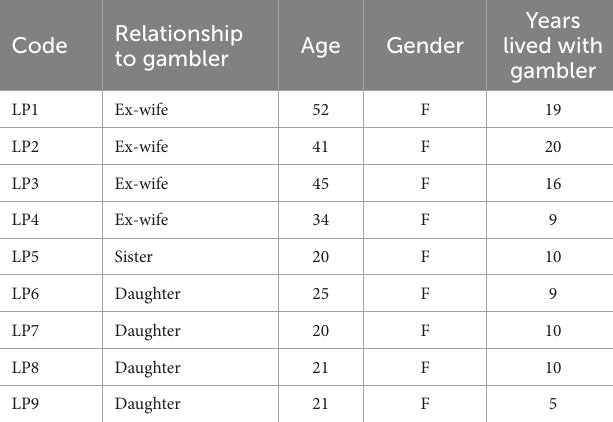
TABLE 1 Participant demographic